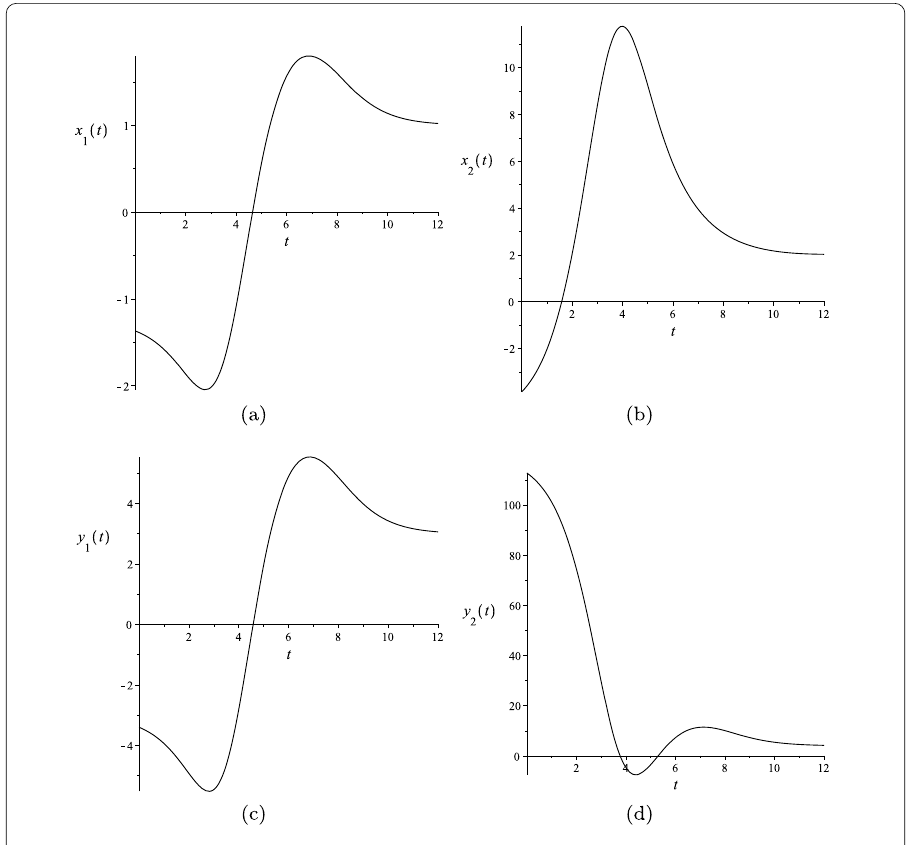
Figure 3 Third-order solitary solutions to (122)–(125): ( a ) x 1 ( t ); ( b ) x 2 ( t ); ( c ) y 1 ( t ); and ( d ) y 2 ( t )